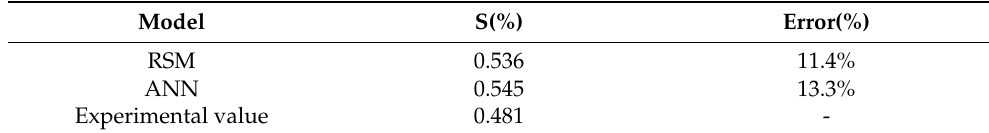
Table 7. Comparison of predicted and experimental values of emulsion film stability under opti- mal